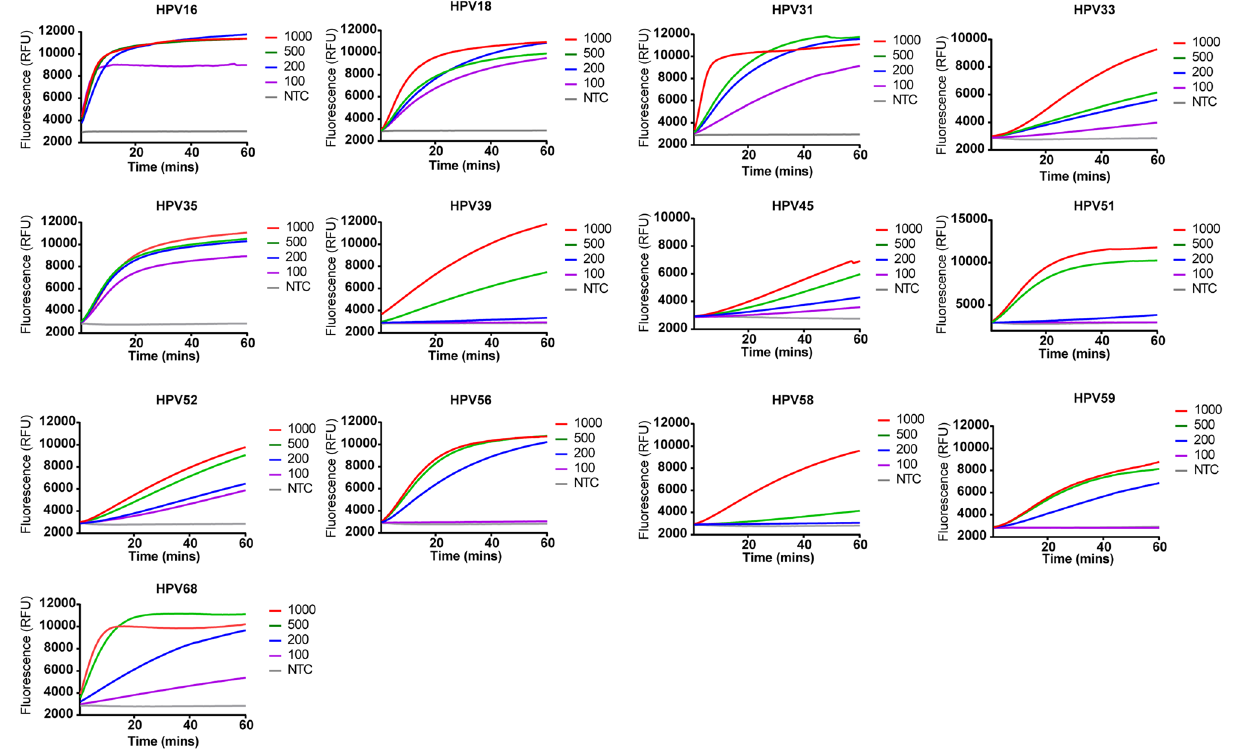
Figure 4. Serial dilutions of the indicated HPV plasmid for LoD determination. After RPA amplification at 37 °C for 20 min using 10,000 copies of plasmid for each reaction, 10 μL of the yield was transferred to 40 μL of the Cas12a mixture for cleavage assays. NTC no-template